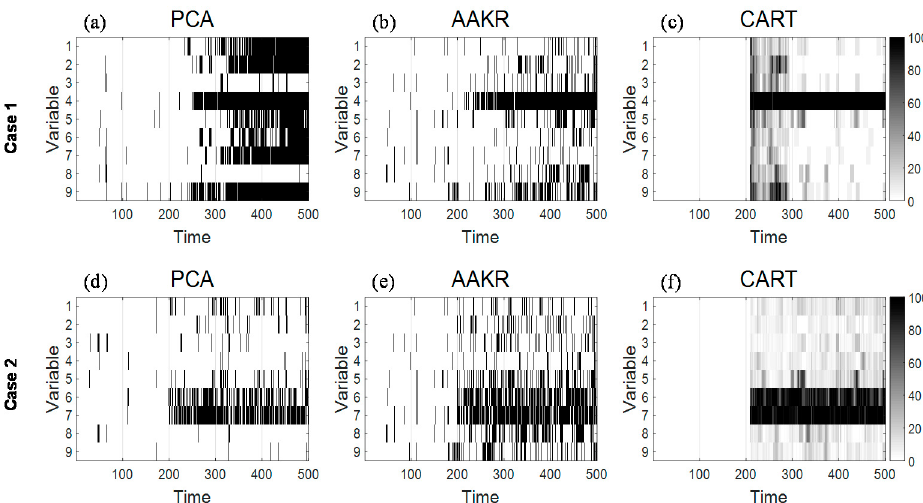
Figure 9. (Artificial fault cases) Fault isolation results of comparison methods and Method 2: ( a ) (Case 1) Q statistic-based contribution plot; ( b ) (Case 1) AAKR-based contribution plot; ( c ) (Case 1) variable importance values with Method 2; ( d ) (Case 2) T 2 statistic-based contribution plot; ( e ) (Case 2) AAKR-based contribution plot; ( f ) (Case 2) variable importance values with Method 2.